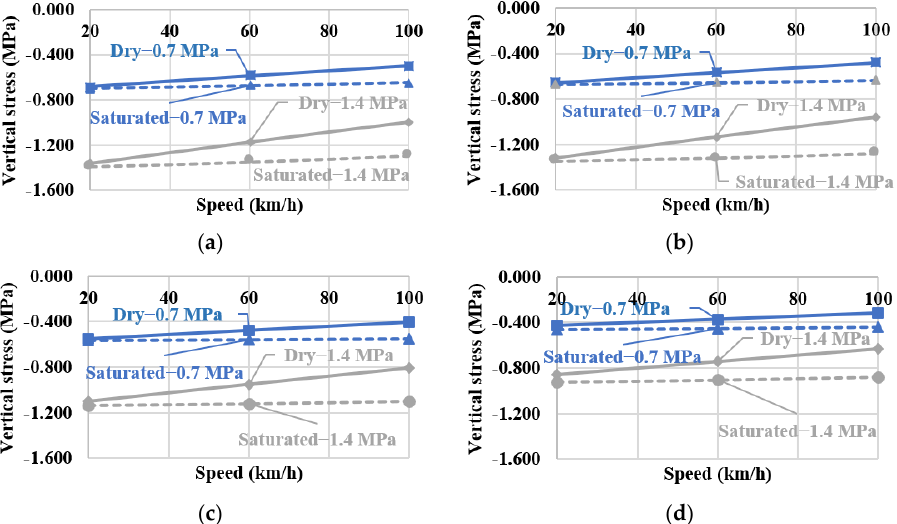
Figure 9. Variation trends of vertical stress in dry and saturated asphalt pavement: ( a ) Surface layer (h = 0 m); ( b ) Upper layer bottom (h = 0.05 m); ( c ) Middle layer bottom (h = 0.11 m); ( d ) Lower layer bottom (h = 0.18 m).